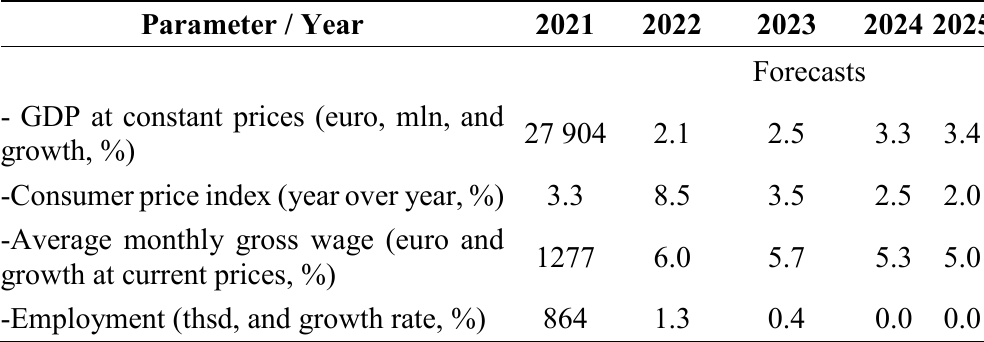
Table 2. Projections Revised in March 2022 for the Development of Latvia’s Stability Program 2022 – 2025, data on the selected indicators (The Ministry